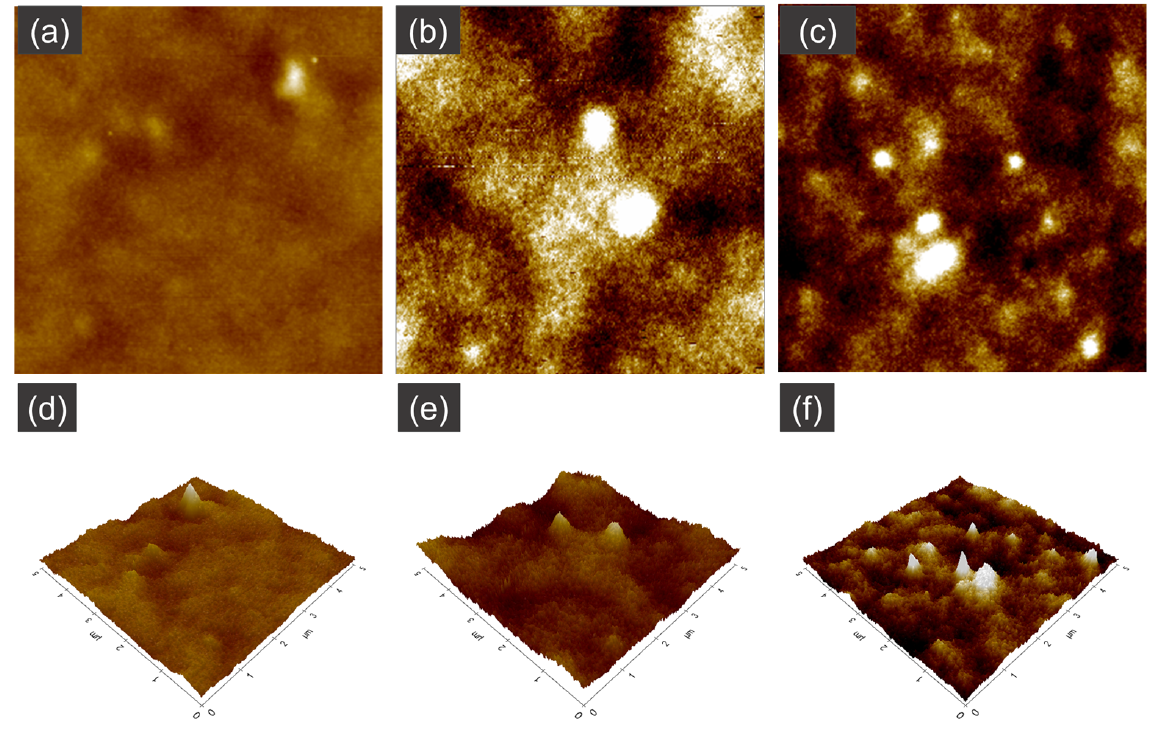
Figure 9. AFM images (5 µ m × 5 µ m) of the top surface of the modified membranes 0.5 MAA3 ( a , d ), 0.5 MAA5 ( b , e ) and 0.5 MAA10 ( c , f ).